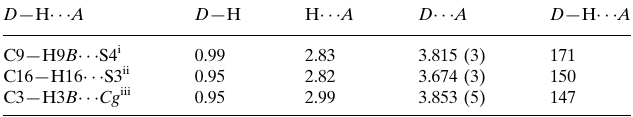
Hydrogen-bond geometry (A˚ , (cid:2) ). Cg is the centroid of the N3/C15–C19